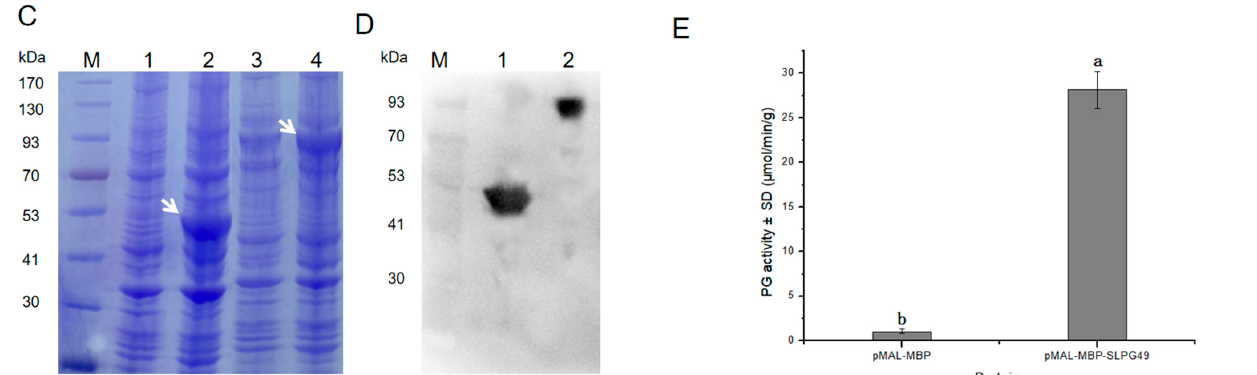
Figure 4. SlPG49 displays PG activity in vitro: ( A , B ) signal peptide analysis and schematic protein structure of SlPG49; ( C ) SDS-PAGE analysis; M, protein maker; 1, not induced pMAL-MBP; 2, induced pMAL-MBP; 3, not induced pMAL-MBP-SlPG49; 4, induced pMAL-MBP-SlPG49. White arrowheads show the bands of pMAL-MBP-SlPG49 and pMAL-MBP; ( D ) western blot analysis; 1: purified pMAL-MBP; 2; purified pMAL-MBP-SlPG49; ( E ) purified pMAL-MBP-SlPG49 shows PG activity in vitro. Data are presented as mean ± SE with at least three biological replicates. Significant differences are indicated by different letters ( p < 0.05).